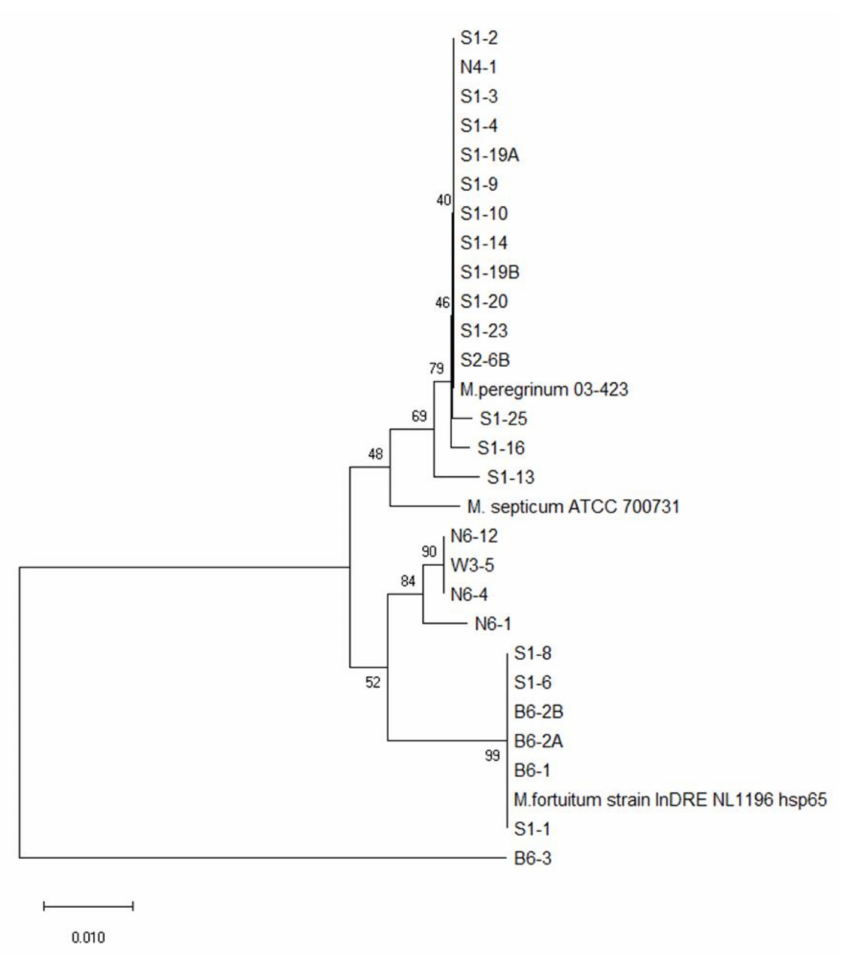
Figure 7. Phylogenetic analysis of RGM isolates in South Korean soils based on the hsp65 gene sequences of the isolates and previously reported strains in NCBI GenBank. The tree was created using the neighbor-joining method, and bootstrap analysis was performed from 1000